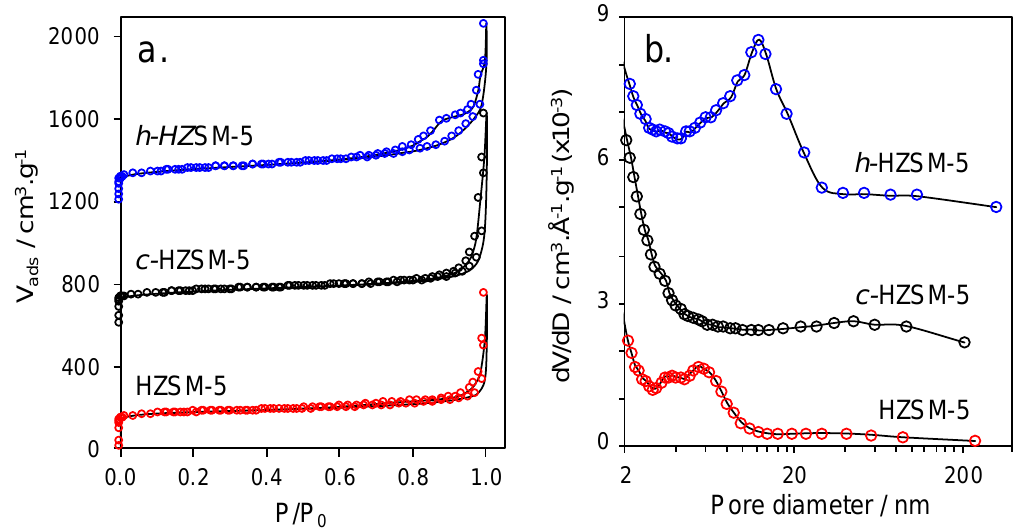
Figure 4. ( a ) N 2 adsorption-desorption isotherms of calcined h-HZSM-5, c-HZSM-5, and HZSM-5, and ( b ) corresponding BJH pore size distributions. Table 2. Textural properties of calcined zeolite ZSM-5